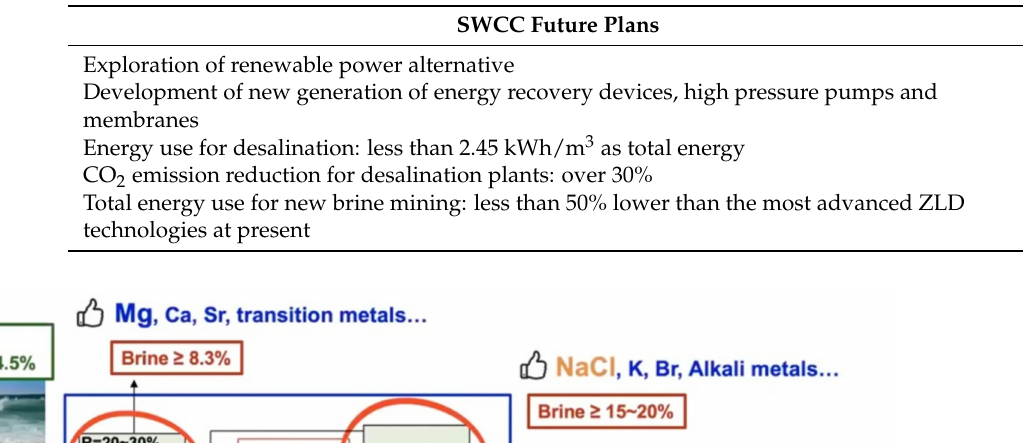
Table 3. SWCC Future plans [42].